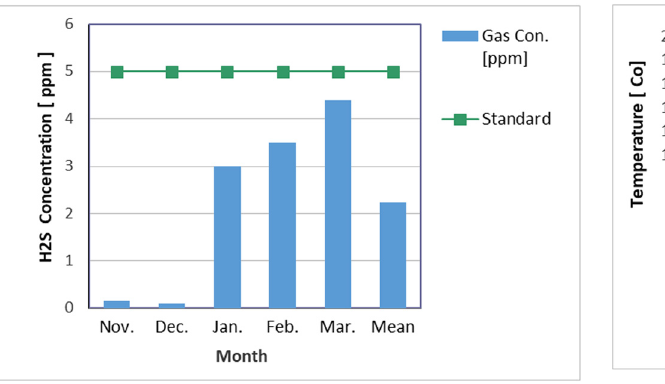
Figure 10: Monthly values and overall mean of temperature during the study period.